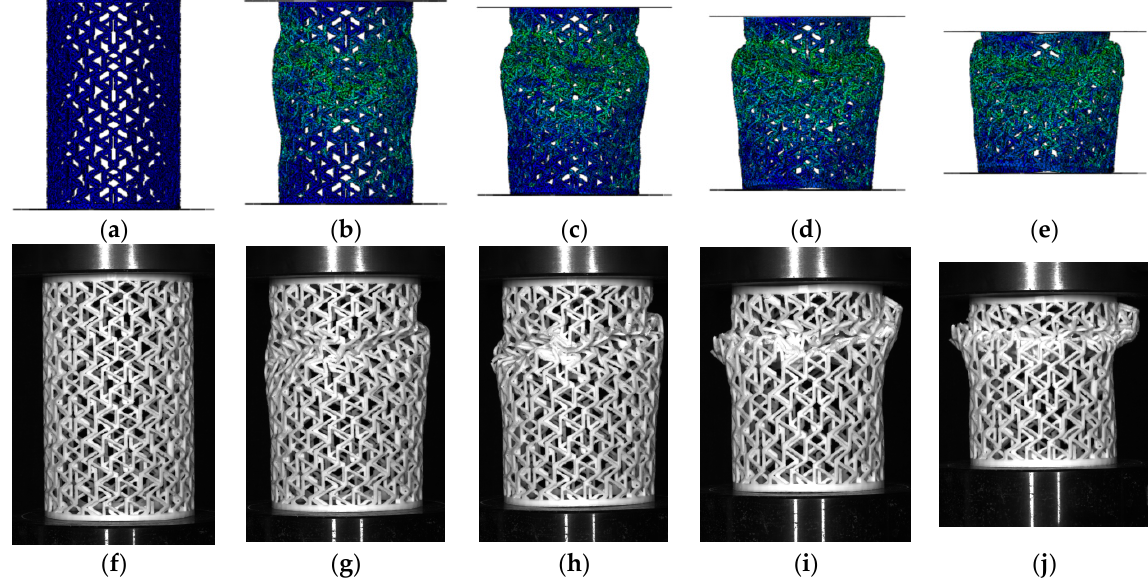
Figure 10. Comparison of the simulated and experimental deformation behaviors of [30°/ − 30°] RHCS: ( a ) 0 mm, ( b ) 8 mm, ( c ) 15 mm, ( d ) 27 mm, and ( e ) 50 mm during simulation; ( f ) 0 mm, ( g ) 8 mm, ( h ) 15 mm, ( i ) 27 mm, and ( j ) 50 mm for the experiments.